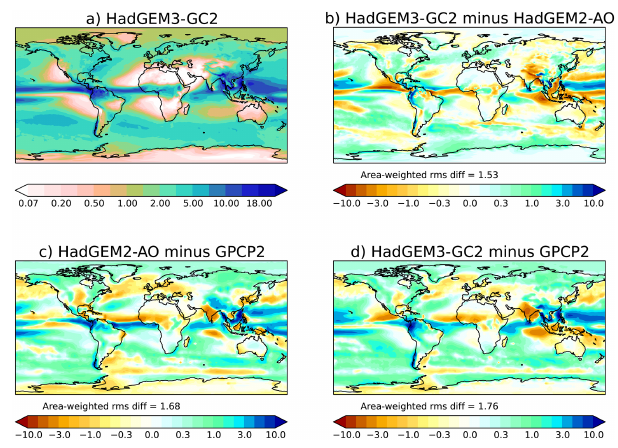
Figure 8. (a) JJA mean precipitation rate (mmday − 1 ) from the HadGEM3-GC2 CLIM experiment, (b) HadGEM3-GC2 minus HadGEM2-AO, (c) HadGEM2-AO minus GPCP observations, (d) HadGEM3-GC2 minus GPCP observations.